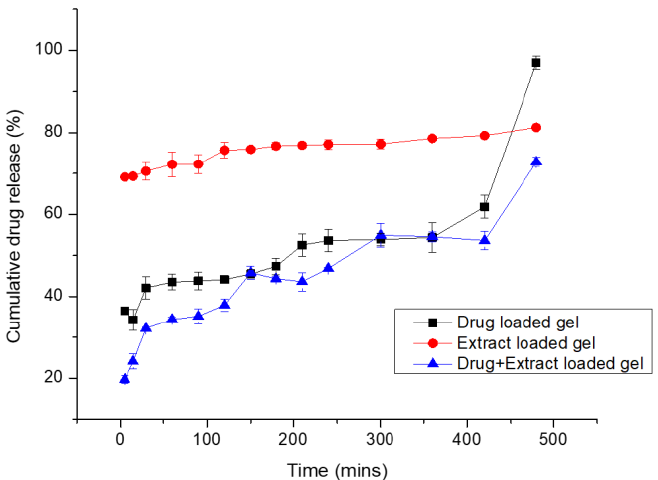
Figure 7. Graph between time (mins) and % release of different gel formulations.